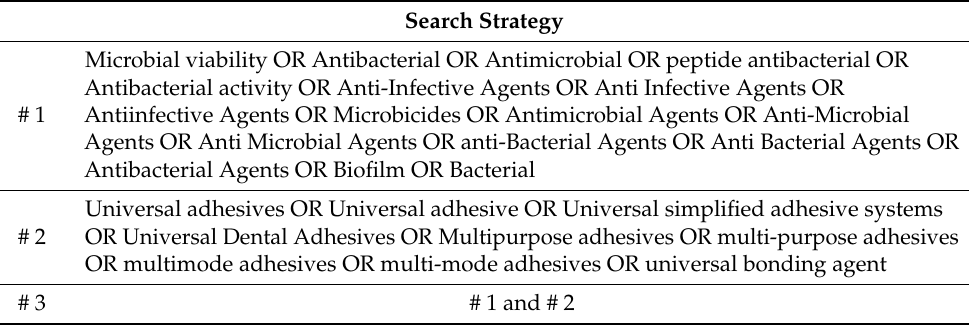
Table 1. Search strategy used in PubMed.